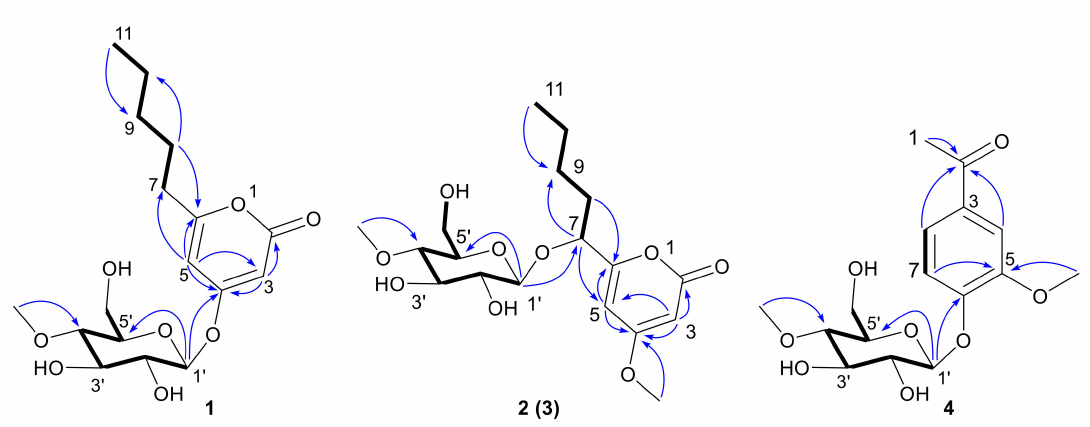
Figure 2. Key 1 H- 1 H COSY (bold stripe) and HMBC (blue arrows) correlations of compounds 1 – 4 . The absolute configuration of compound 1 was confirmed by single-crystal X-ray diffraction using Cu K α radiation. The perspective oak ridge thermal ellipsoid plot (OR- TEP) plot is shown in Figure 3. Thus, the sugar residue was confirmed as 4-methoxy- β -D-glucosyl and allowed an unambiguous assignment of the absolute configuration as 1 (cid:48) S ,2 (cid:48) R ,3 (cid:48) R ,4 (cid:48) S ,5 (cid:48) R , therefore compound 1 was characterized as 4-(4 (cid:48) -methoxy- β -D- glucosyl)-6-pentyl-2-pyrone.